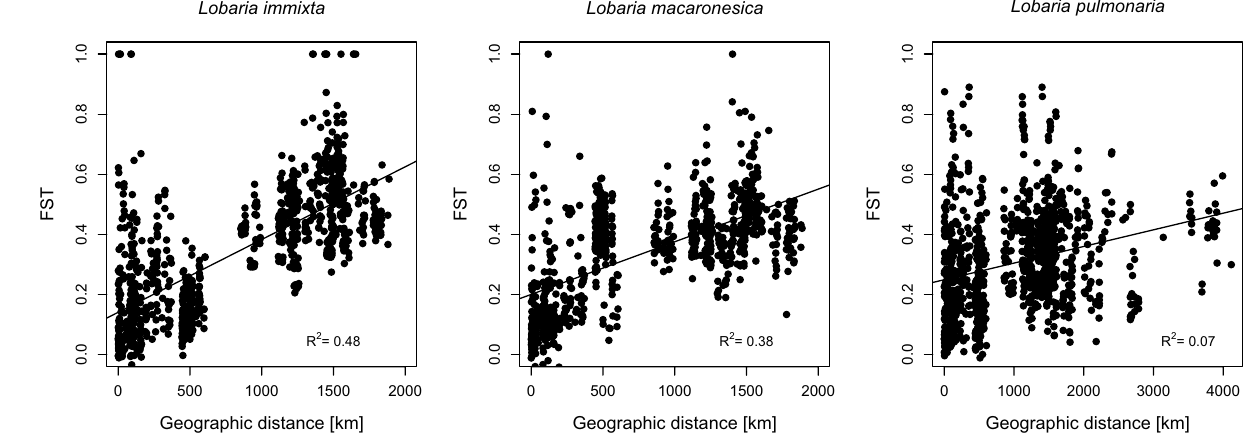
Figure 5. Analysis of isolation by distance, showing the relationship between F ST and geographic distance in Lobaria immixta , L. macaronesica and L. pulmonaria from Macaronesia. All species exhibited a significant relationship. The figure was created in R 3.6.1, https:// cran.r- proje ct.